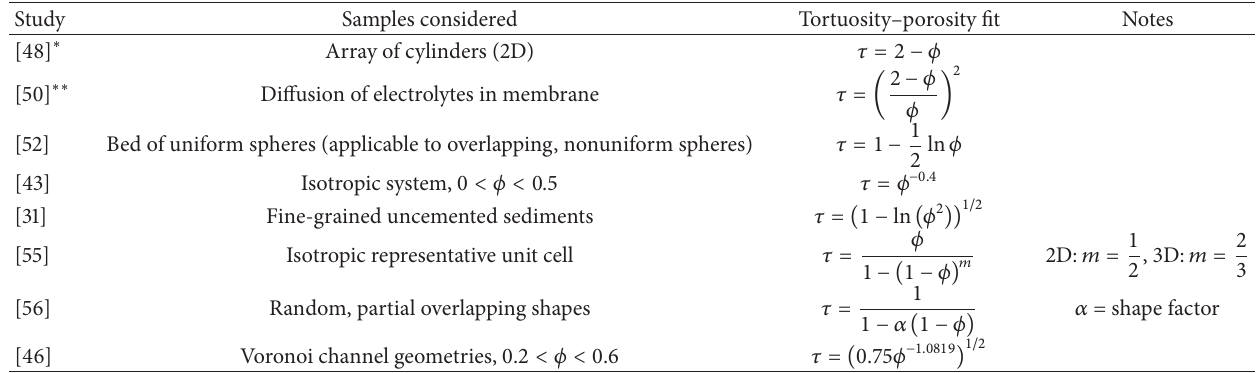
Table 3: Past work on diffusive